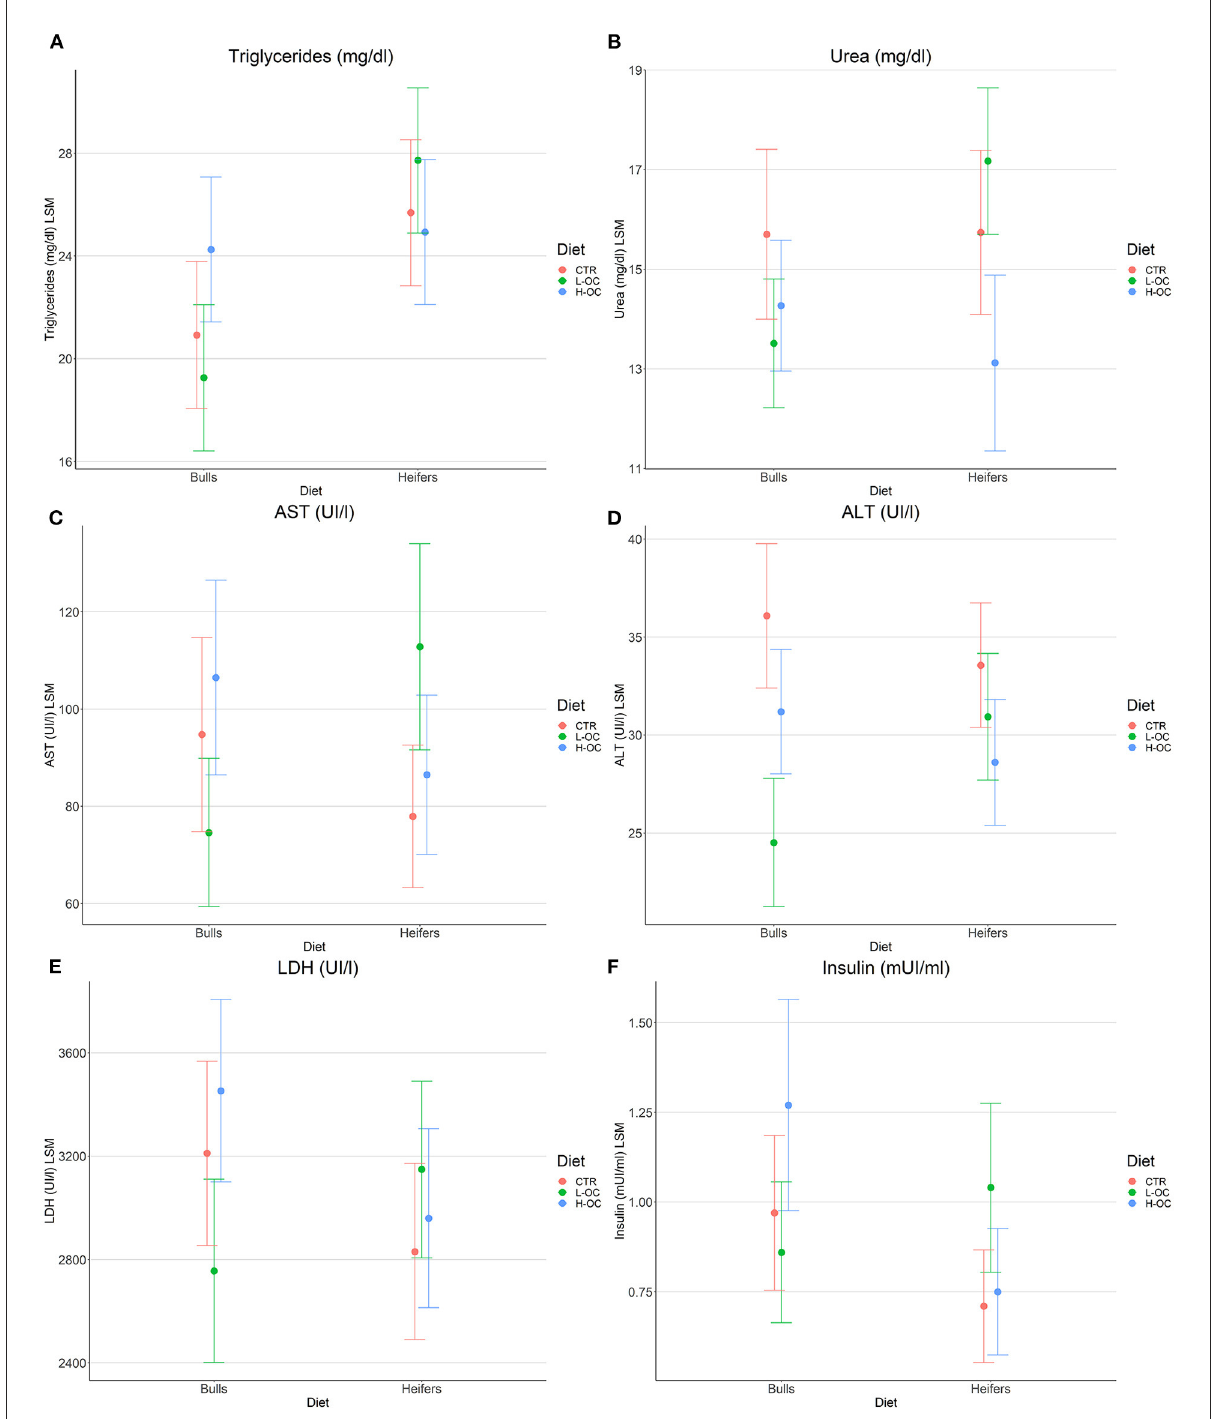
FIGURE3 Significant effect of the diet x sex interaction on total triglycerides (A) , urea (B) , AST (C) , ALT (D) , LDH (E) , and insulin (F) . The parameters’ least square mean (LSM) and standard error are represented for both the sexes and all the groups with different olive cake inclusions, namely control (CTR, 0%), Low-olive cake (L-OC, 10%), and High-olive cake (H-OC, 15%)